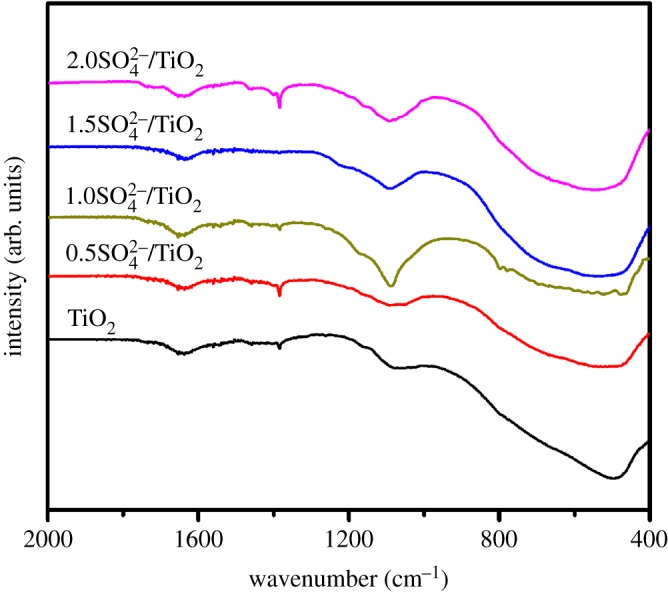
FT-IR spectra of the TiO2 and SO42−/TiO2 samples.